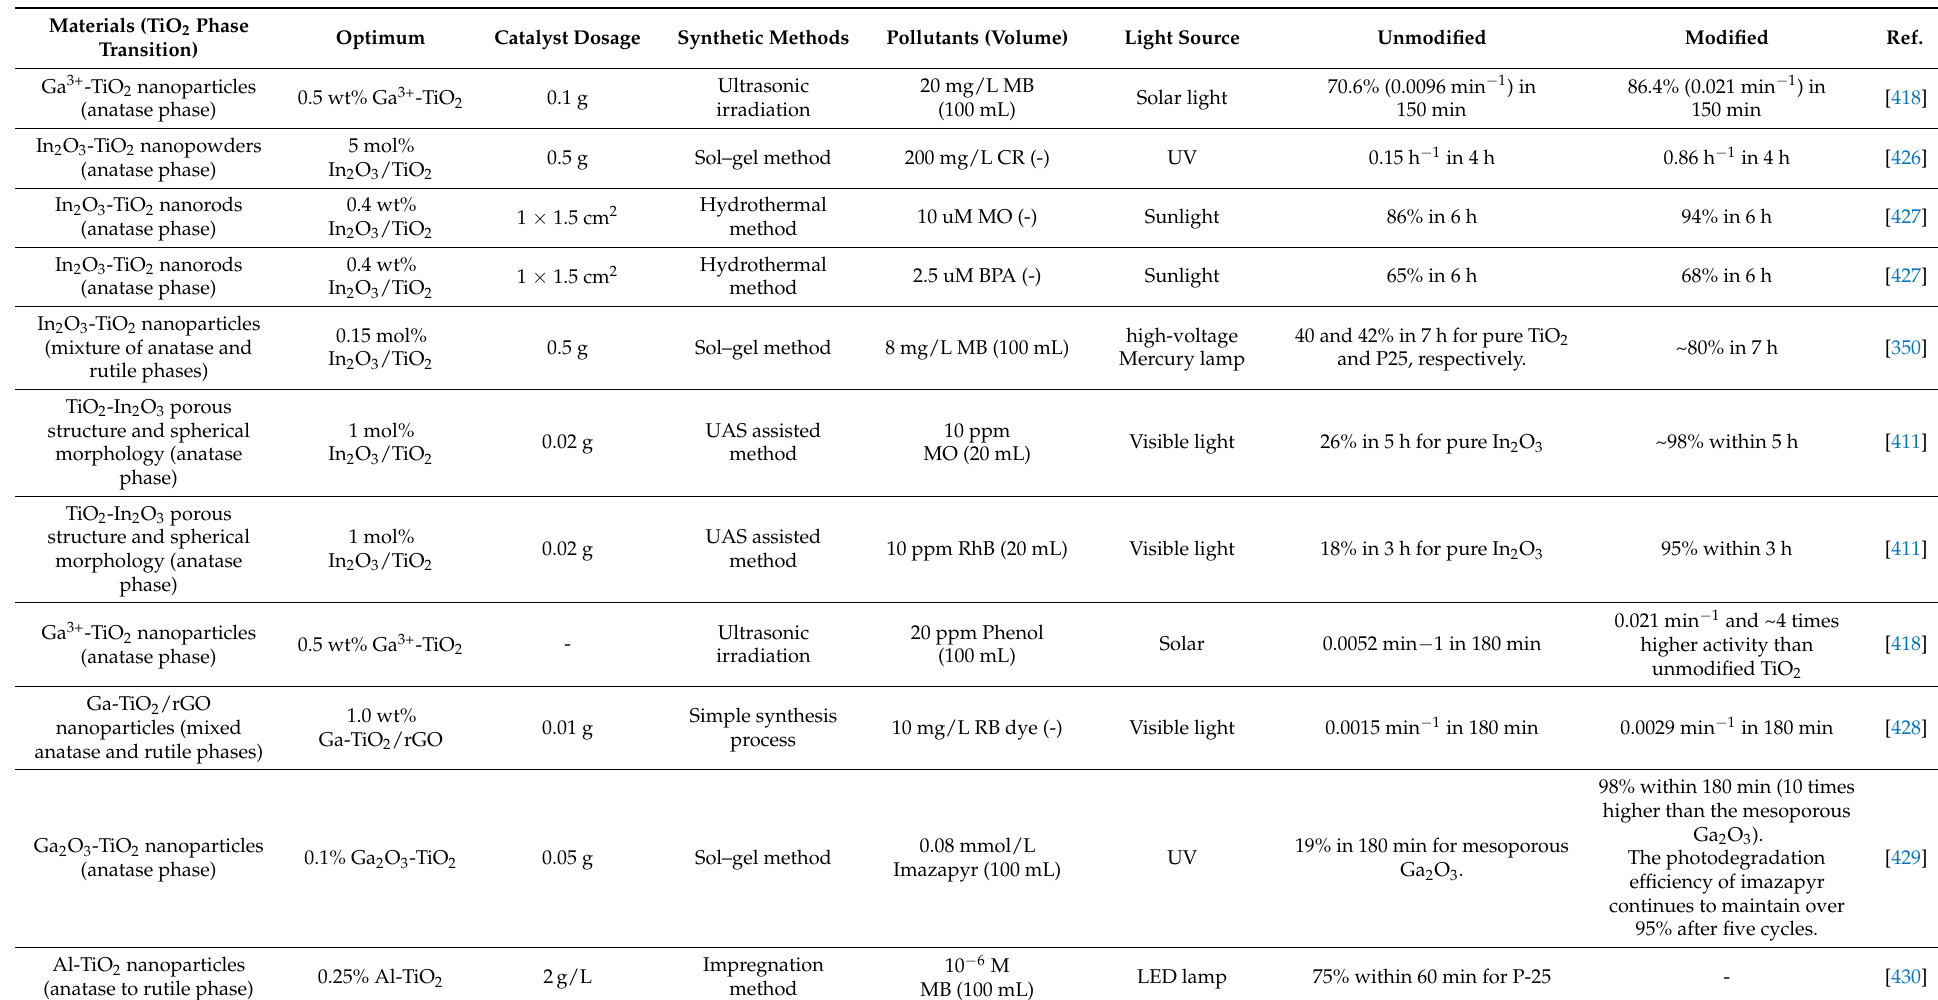
Table 22. Summary of recent progress on other metals modified TiO 2 photocatalysts for organic pollutants